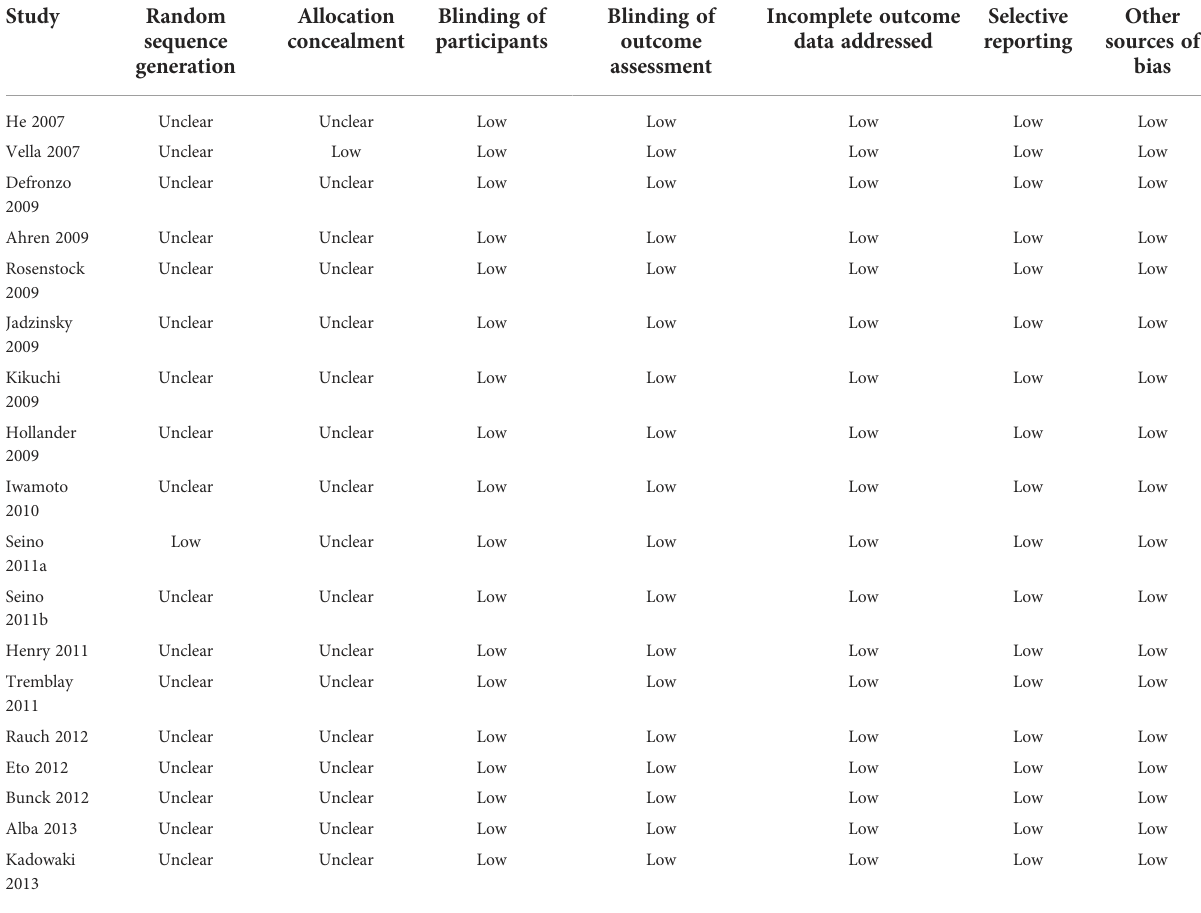
TABLE 2 Details of study quality evaluation via the Cochrane ’ s Risk of Bias Tool. Comparisons between DPP4 inhibitors and other